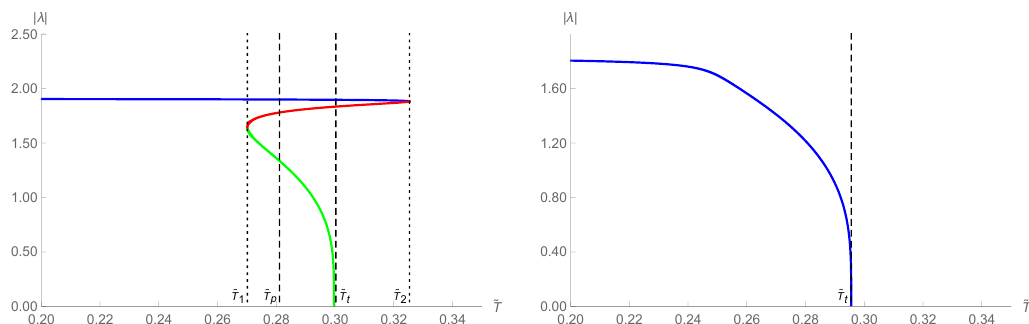
Figure 8 . The modulus of the Lyapunov exponent | λ | of stable time-like circular orbits as a function of the temperature ˜ T for massive particles with L = 20 l in RN-AdS black holes with ˜ Q = 0 . 11 < ˜ Q ˜ Q = 0 . 20 > ˜ Q c ( Left ) and c ( Right ). The behavior of Lyapunov exponents in the stable case is strikingly similar to that in the unstable